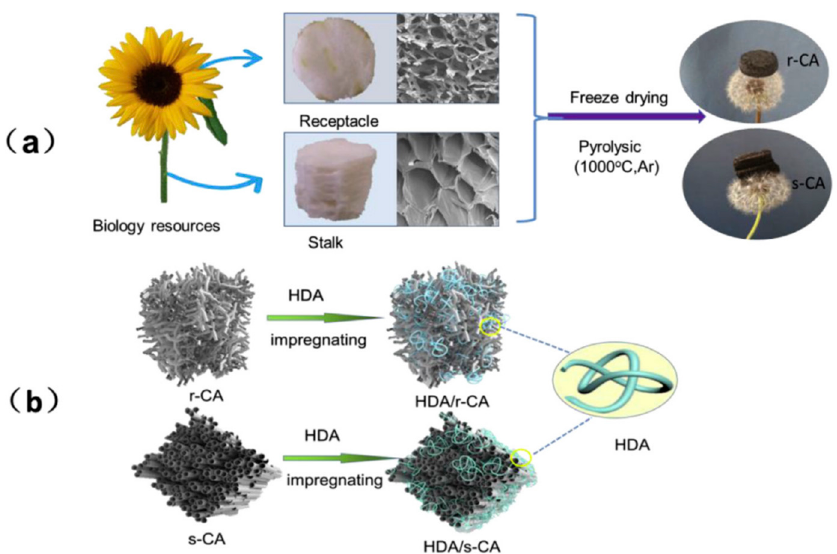
Figure 7. ( a ) Preparation routes of carbon aerogel, ( b ) Schematic illustration of 1-hexadecanamine/ carbon aerogel composite PCMs